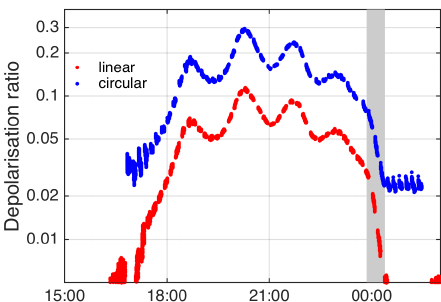
Figure 8. An example of alternating measurements of the linear and the circular depolarization ratios during RUN_-30C. Both depolar- ization ratios show oscillations with consistent minima and maxima. The shape transition is indicated by the grey area.